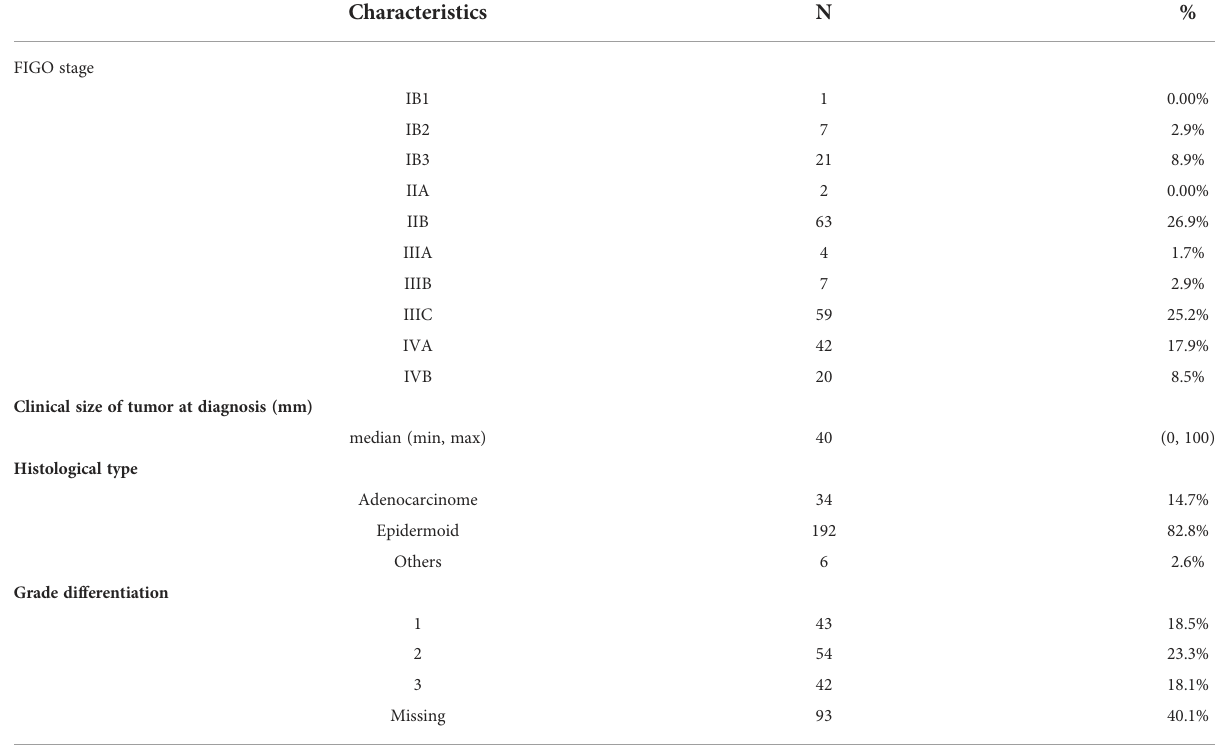
FIGO, Federation of Gynecology and